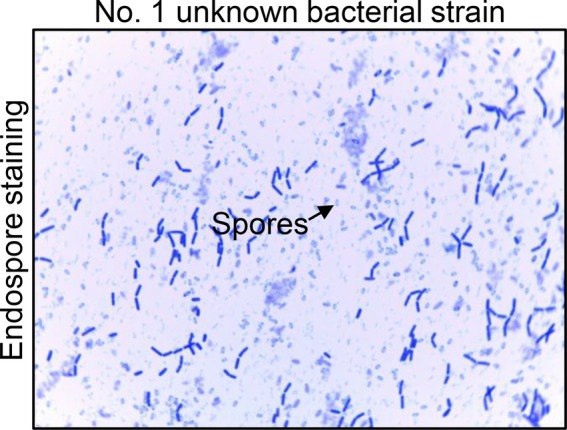
The endospore staining of No. 1 unknown bacterial strain. Endospore staining to analyze the characteristic of No. 1 unknown bacterial strain. The arrows show the forming spores of this unknown bacterium.